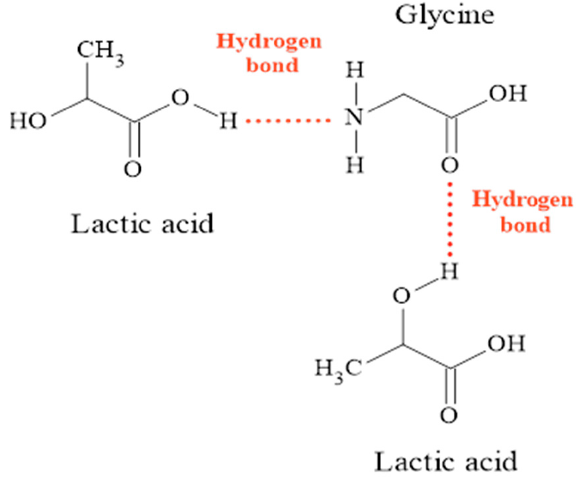
Figure 2. Preferential interactions between lactic acid and glycine.